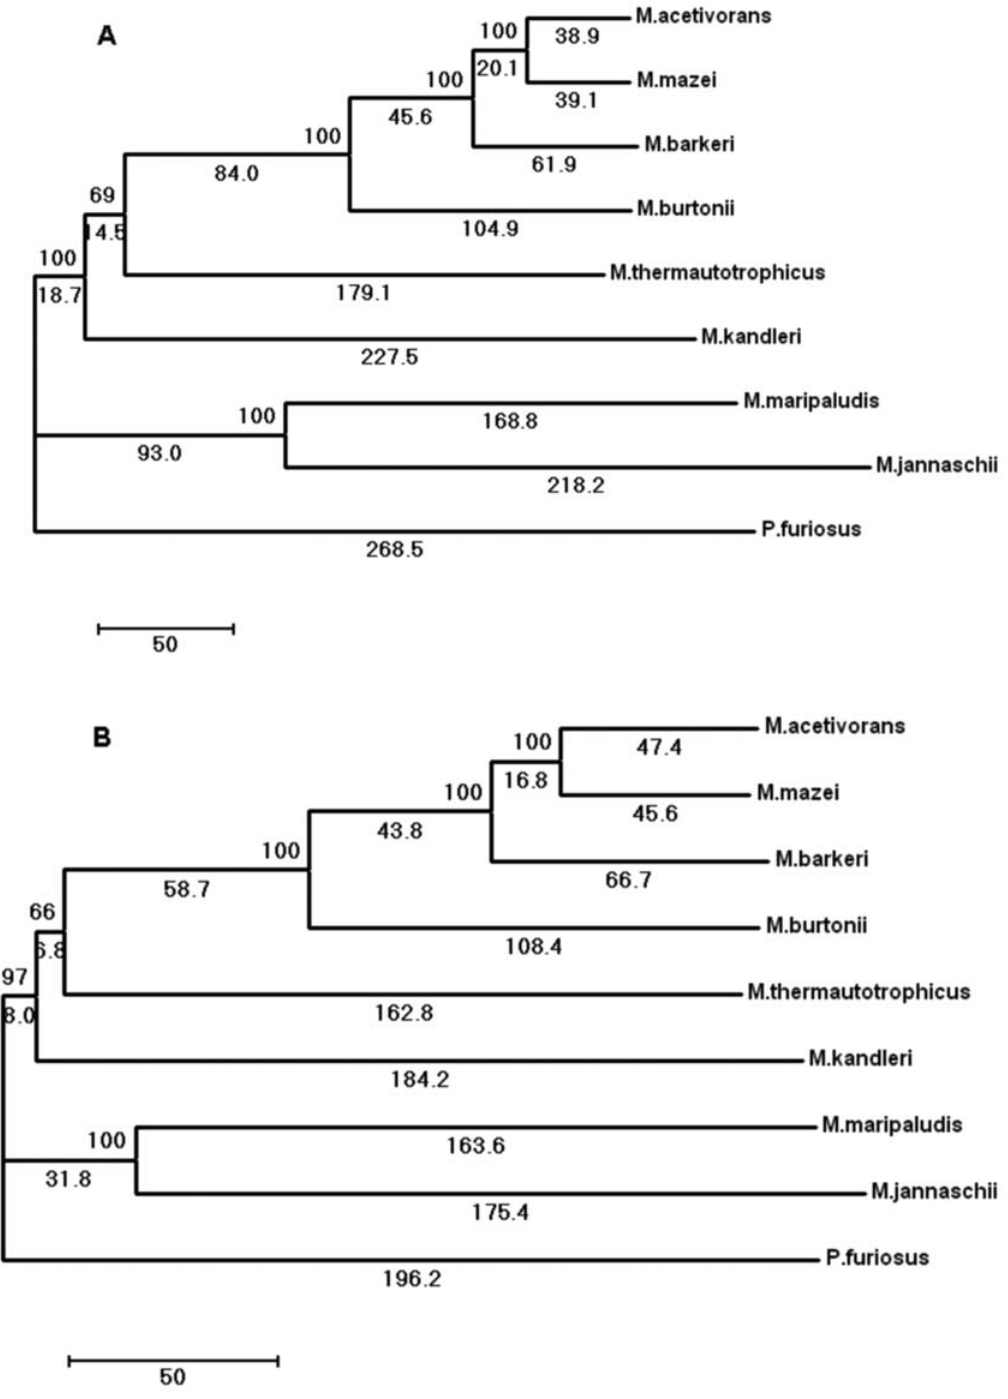
Figure 1. Phylogeny of eight methanogenic genomes inferred from (A) an empirically derived estimator (EDE) distance and (B) a breakpoint distance matrix. Values at nodes show the number of times that the clade defined by that node appears in the 100 jackknife trees. Values under branches and the scale bar show the number of genome rearrangement events. Pyrococcus furiosus was used as an outgroup.